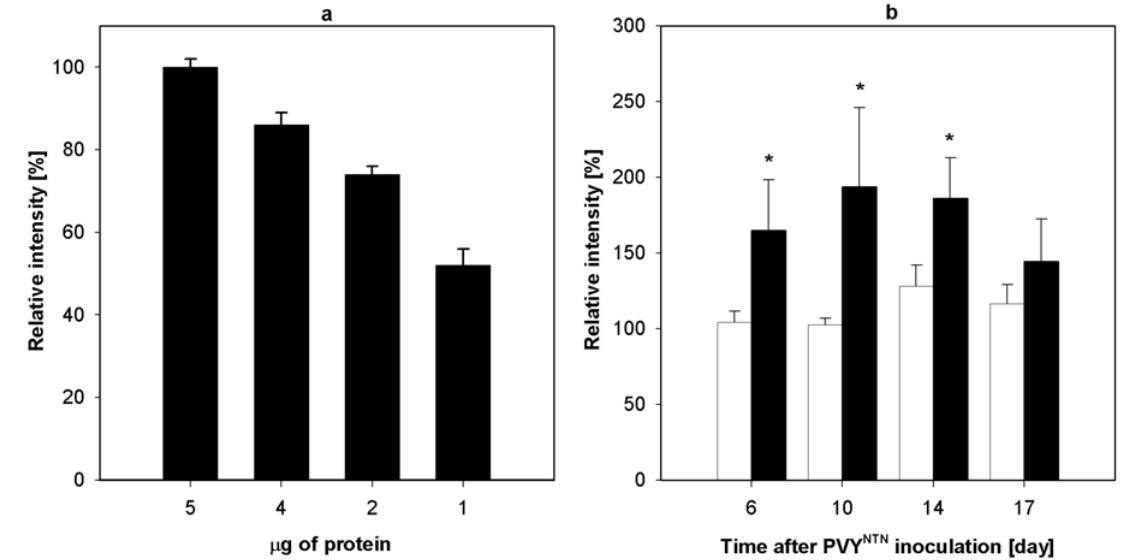
Figure 5. Immunochemical detection of NADP-ME. (a) Test of linearity of Western blot analysis signal using various quantities of purified NADP-ME protein from Nicotiana tabacum L. leaves. Estimated relative molecular mass according to standard protein was 66,000. Plot indicates decrease in relative intensity of signal (expressed in %) evaluated densitomerically by Elfoman 2.0. (b) Detection of NADP-ME protein in control (white columns) and PVY NTN infected (black columns) leaves collected 6 th -17 th day after inoculation by Western blot